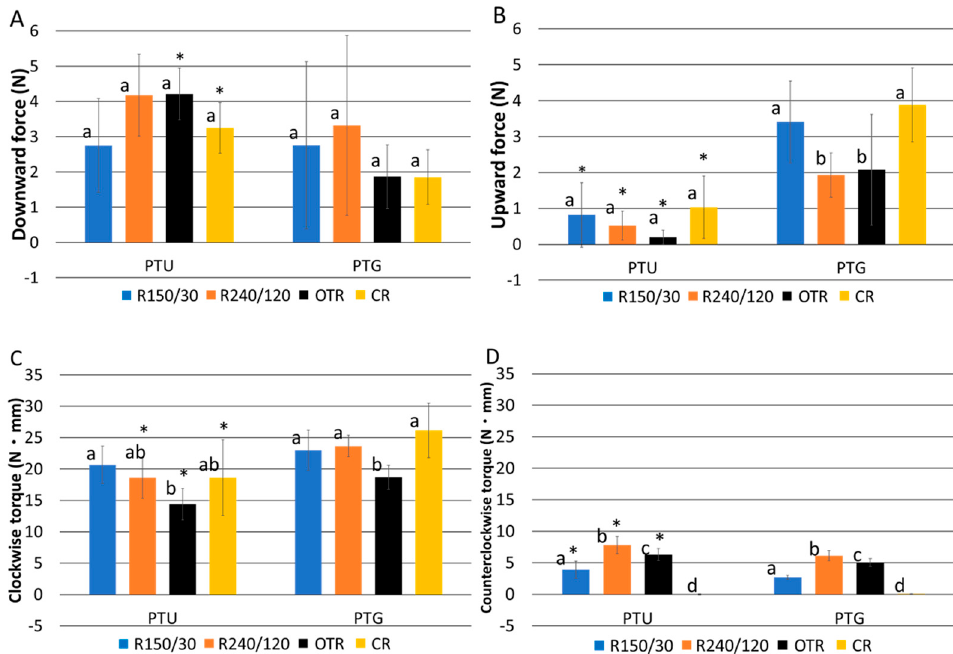
Figure 1. The maximum values of ( A ) downward force, ( B ) upward force, ( C ) clockwise torque, and ( D ) counterclockwise torque during root canal instrumentation. Data represent the mean and standard deviation (n = 10). Different letters indicate a significant difference ( p < 0.05) between groups within the same instrument. Asterisks indicate a significant difference compared with corresponding values for the PTG group ( p < 0.05).